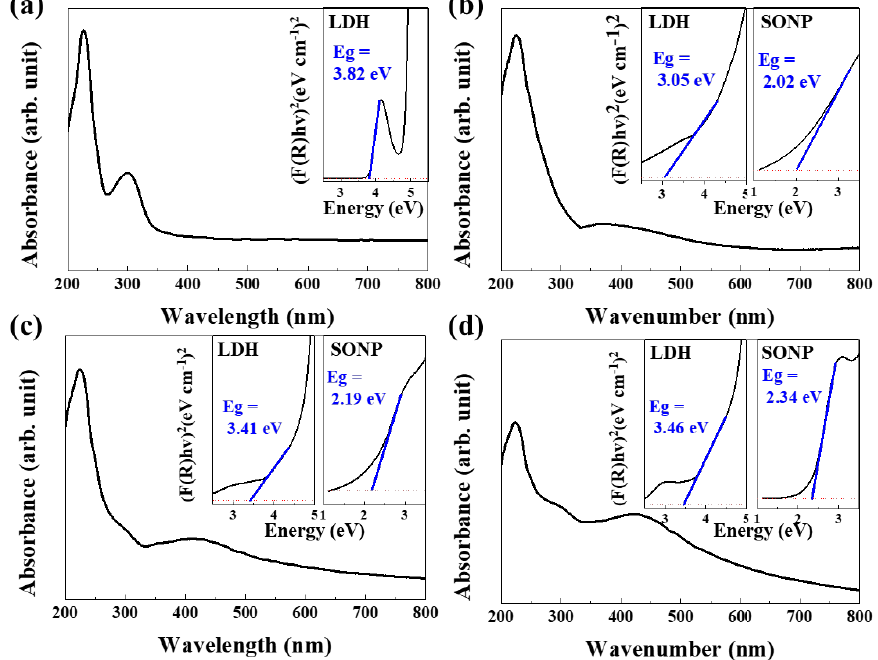
Figure 5. Diffuse reflectance UV-visible absorption spectra of ( a ) pristine MgAl – citrate LDH, ( b ) SONP@LDH-1, ( c ) SONP@LDH-1/3 and ( d ) SONP@LDH-1/10. Kubelka – Munk-transformed reflectance spectra and band-gaps were displayed as insets.